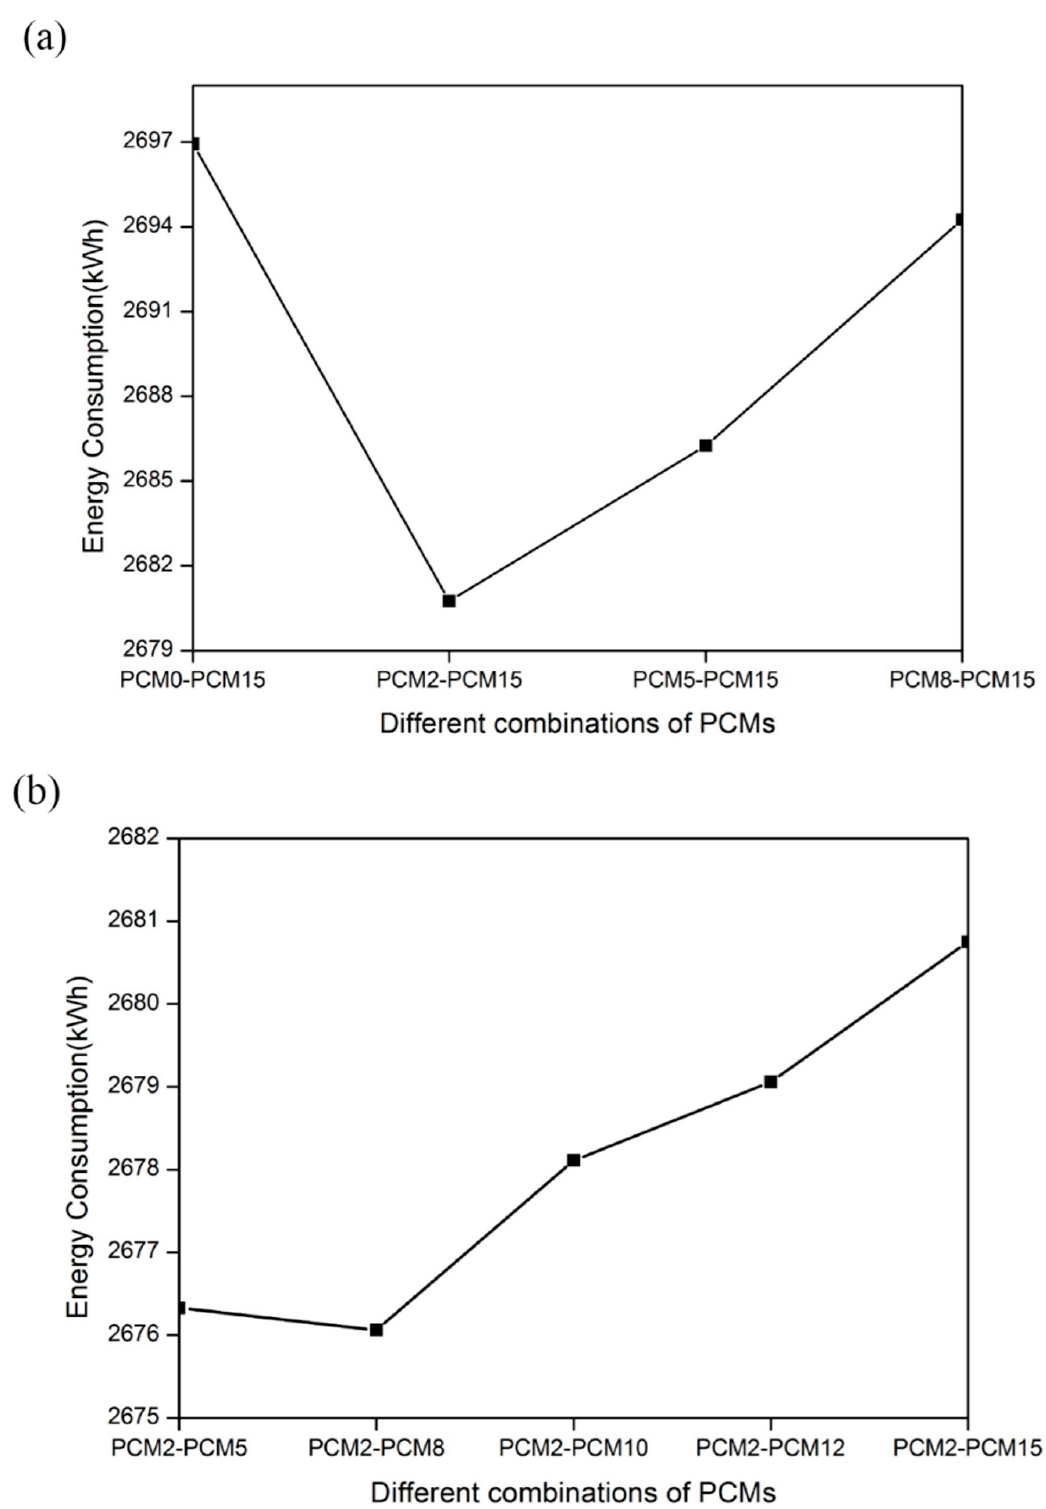
Figure 3. The energy consumption of the room with different PCMs installed on ( a ) the roof and ( b ) the south wall.